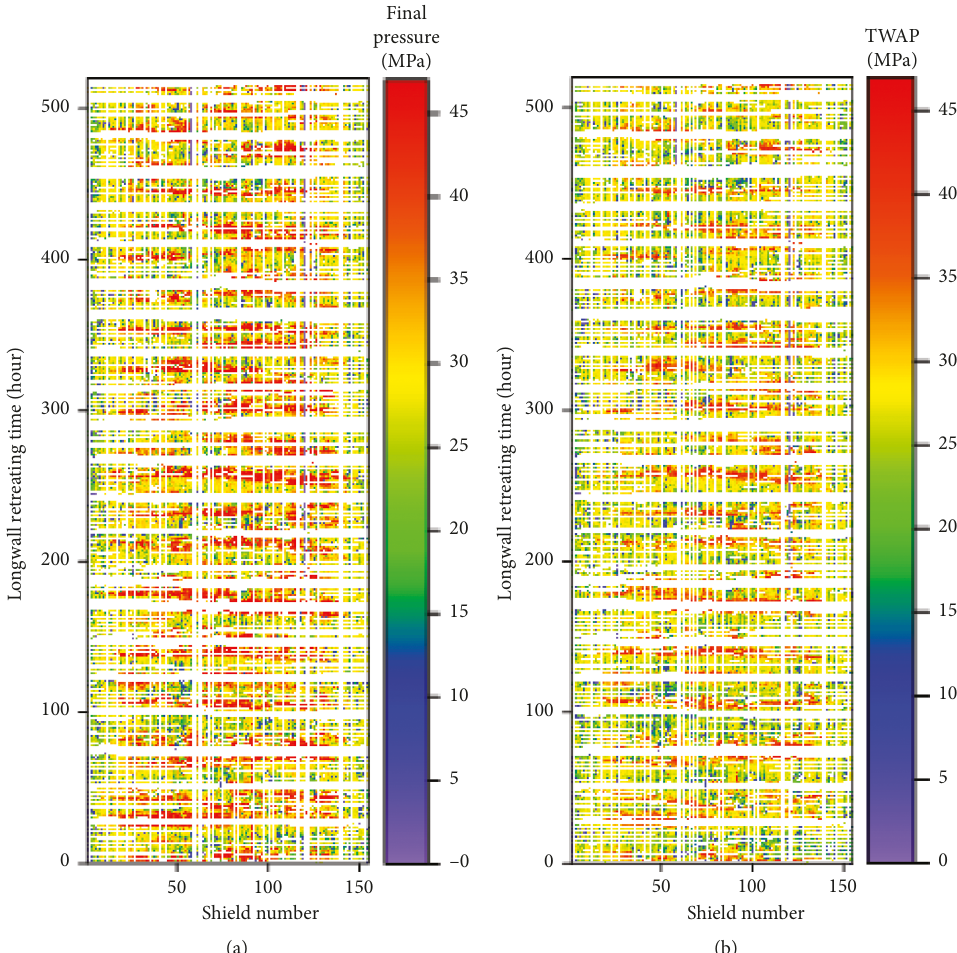
Figure 2: Evolution of (a) final pressure and (b) time-weighted average pressure (TWAP) with longwall retreating time in Panel LW22306 of Bulianta mine.